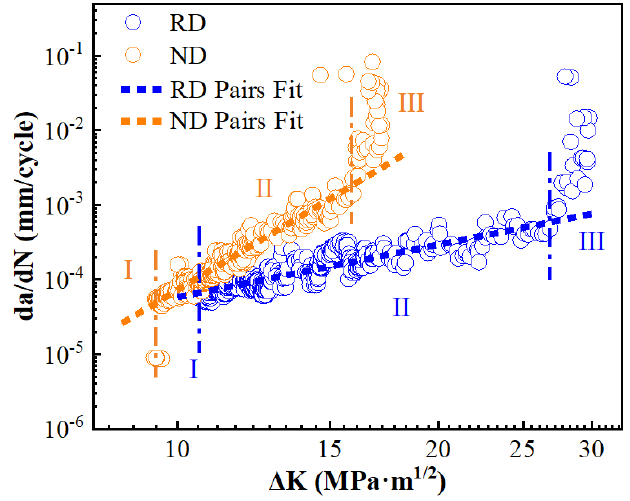
Figure 8. FCGR under different loading directions. Table 2. Material parameters in the Paris power equation and values of da/dN at the specific ∆ K. Loading